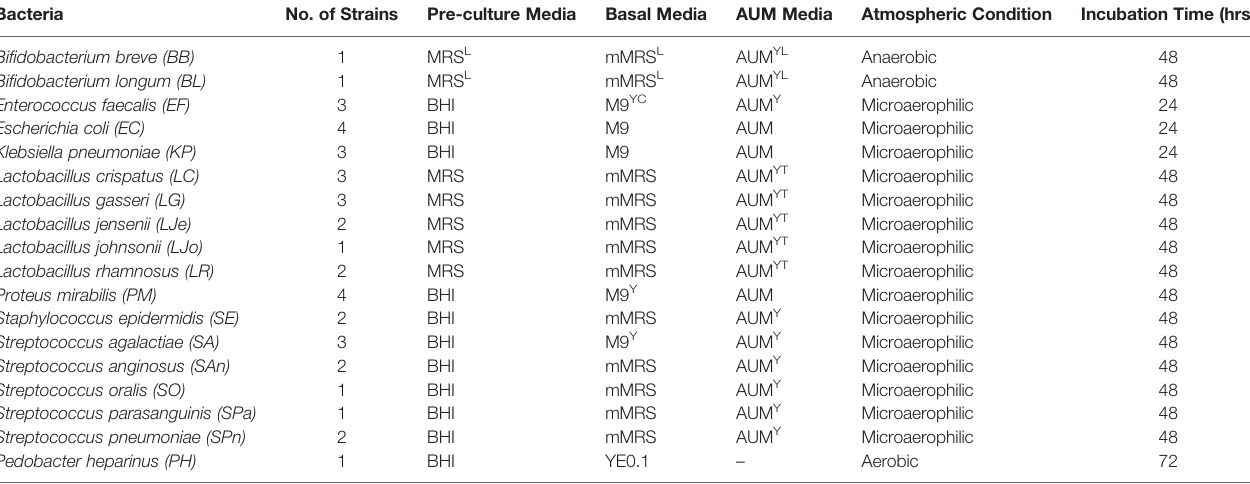
TABLE 1 | Strain list and experimental conditions.